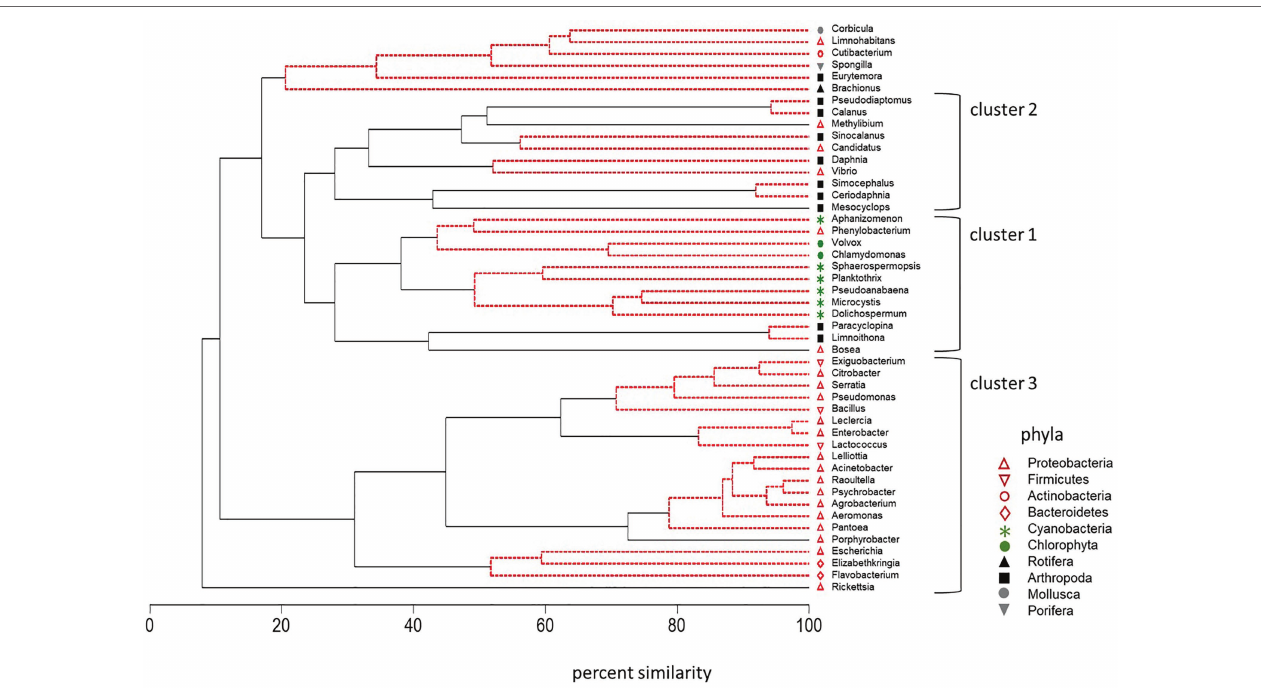
FIGURE 8 | Dendrogram of cluster analysis combined with SIMPROF of DNA sequences for 10 phyla across trophic levels in surface samples collected in the summer and fall of 2014, 2016, and 2017. Type 3 SIMPROF (5% significance level) identified phyla that were significantly different (black solid line) or not significantly different (red dashed